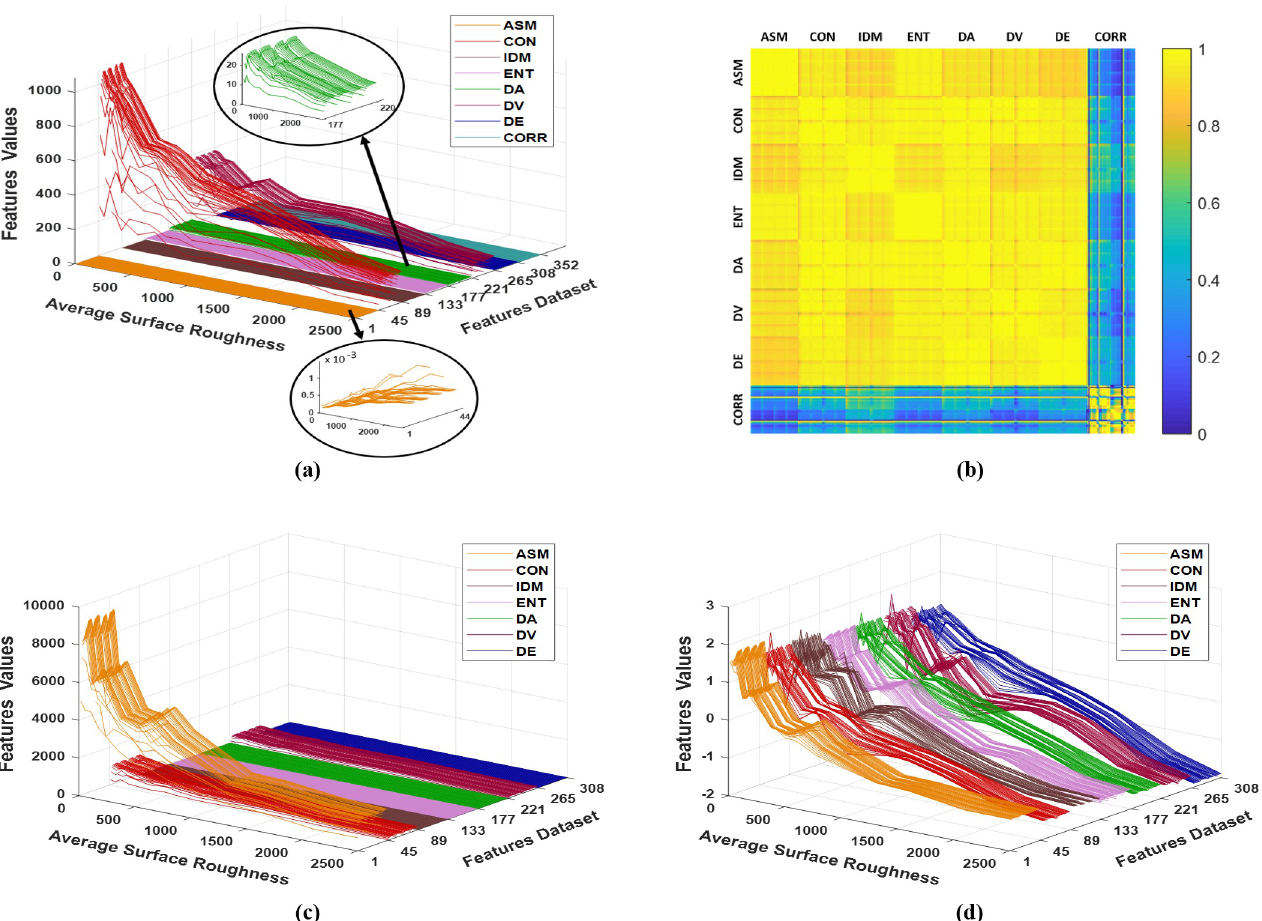
Fig 9. The distribution of the statistical features, 44 features for each Haralick’s statistical parameter, computed from the twelve cross-section areas of articular cartilage tissue: (a) the initial statistical features dataset, (b) the pairwise correlation matrix of the statistical features, (c) the statistical features dataset after having the same rating and removing the 44 statistical features of CORR, and (d) the final statistical features dataset after standardization to be analyzed by PCA, where they range from -1.92 to 2.09.